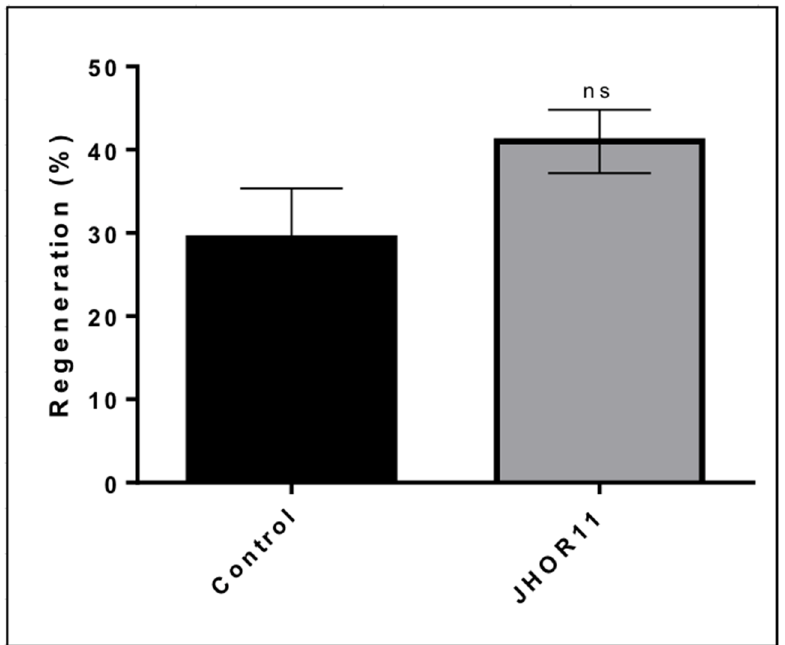
Figure 11. Percentage of wound scratch closure after 24 h incubation with IC 50 JHOR11 and 0.1% ( v / v ) DMSO, as a vector control. Bars represent the mean ± SEM of two independent experiments. n.s.— p value not significant.